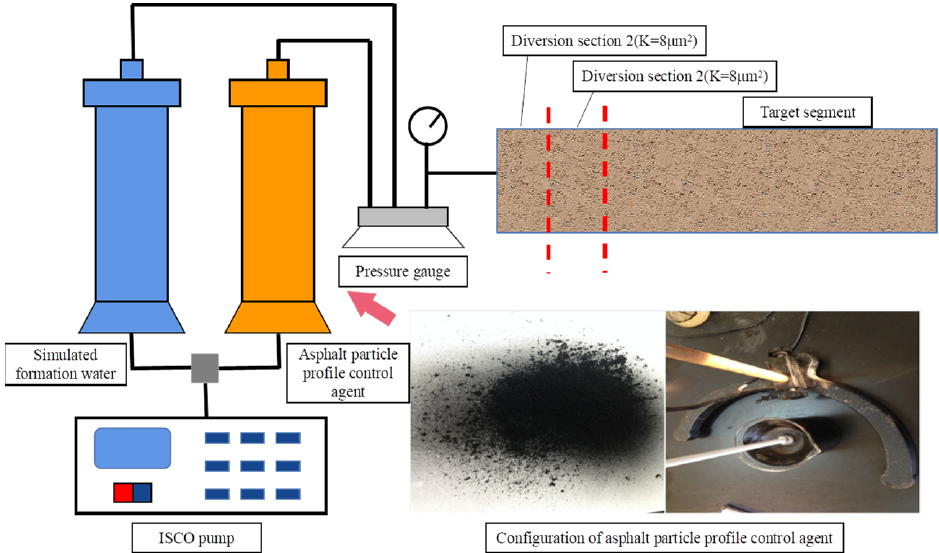
Figure 2. Experimental device and process.